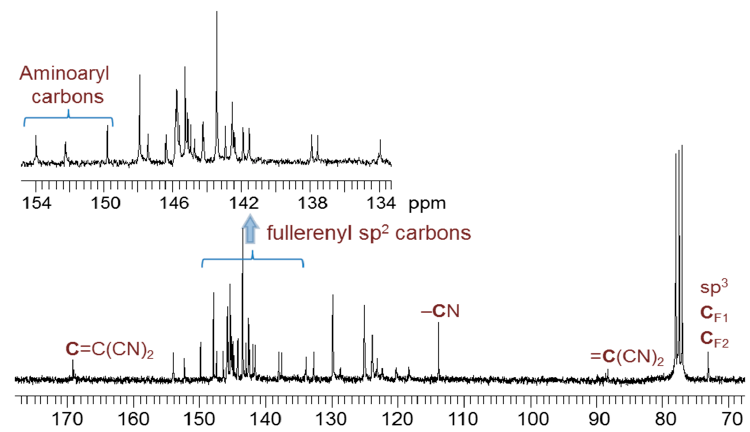
Figure 2. 13 C-NMR spectrum of C 60 (>CPAF-C 18 ) showing all sp 2 ( δ 134–148) and two sp 3 (C F1 and C F2 )